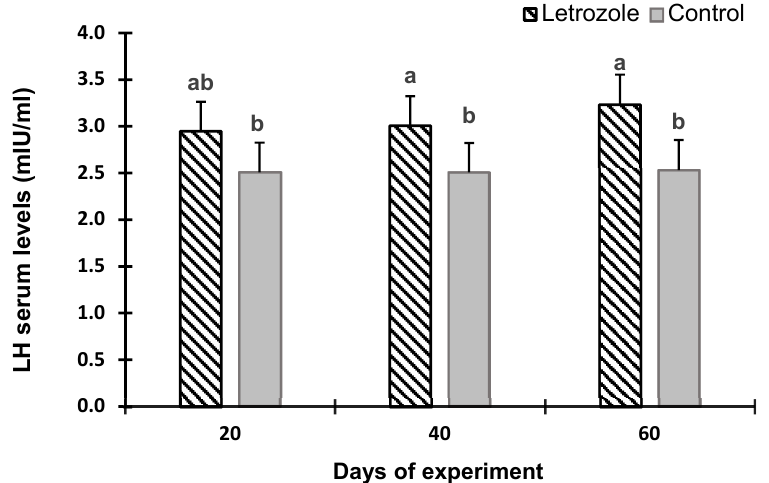
466 Figure 6. Luteinizing hormone (LH) levels in Markhoz bucks treated letrozole (0.25 mg/kg BW/wk) or control. Error bars indicate standard devia- Figure 6. LH levels in Markhoz bucks treated letrozole (0.25 mg/kg BW/week) or control. Error bars 467 tion. a,b Statistically significant differences (p<0.05) between the groups. indicate standard deviation. Statistically significant differences (p<0.05) between the groups.